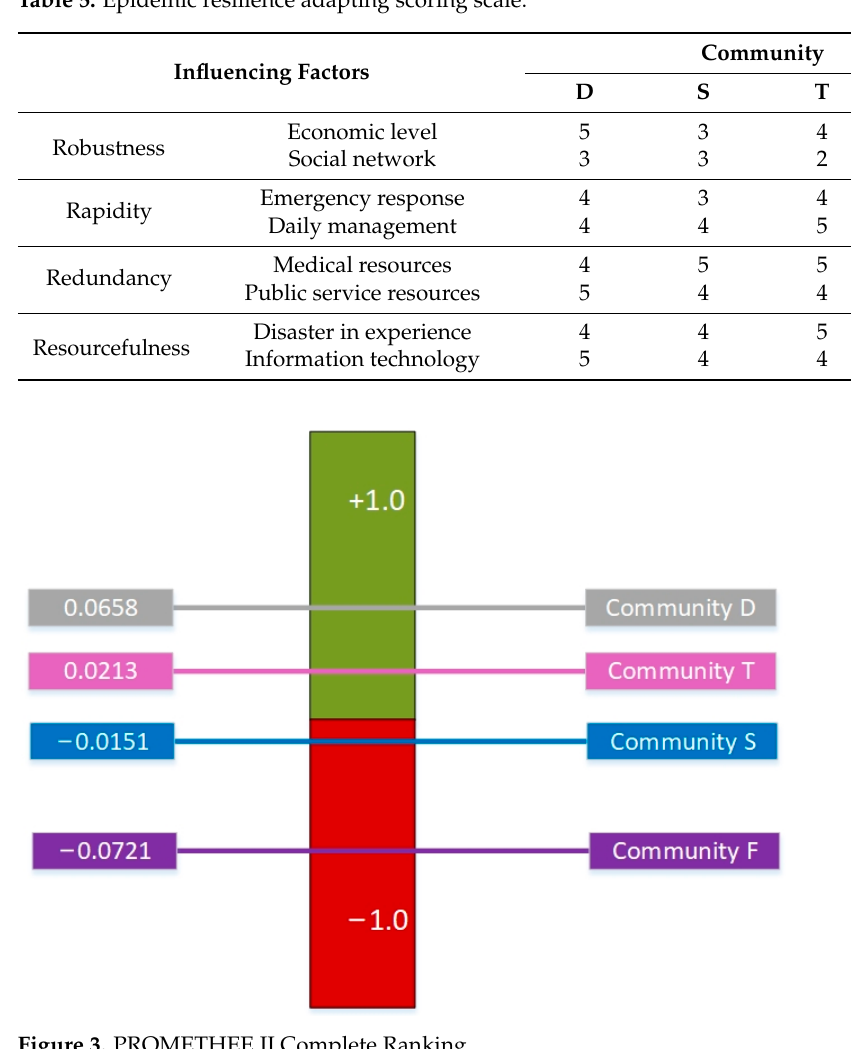
Figure 3. PROMETHEE II Complete Ranking.